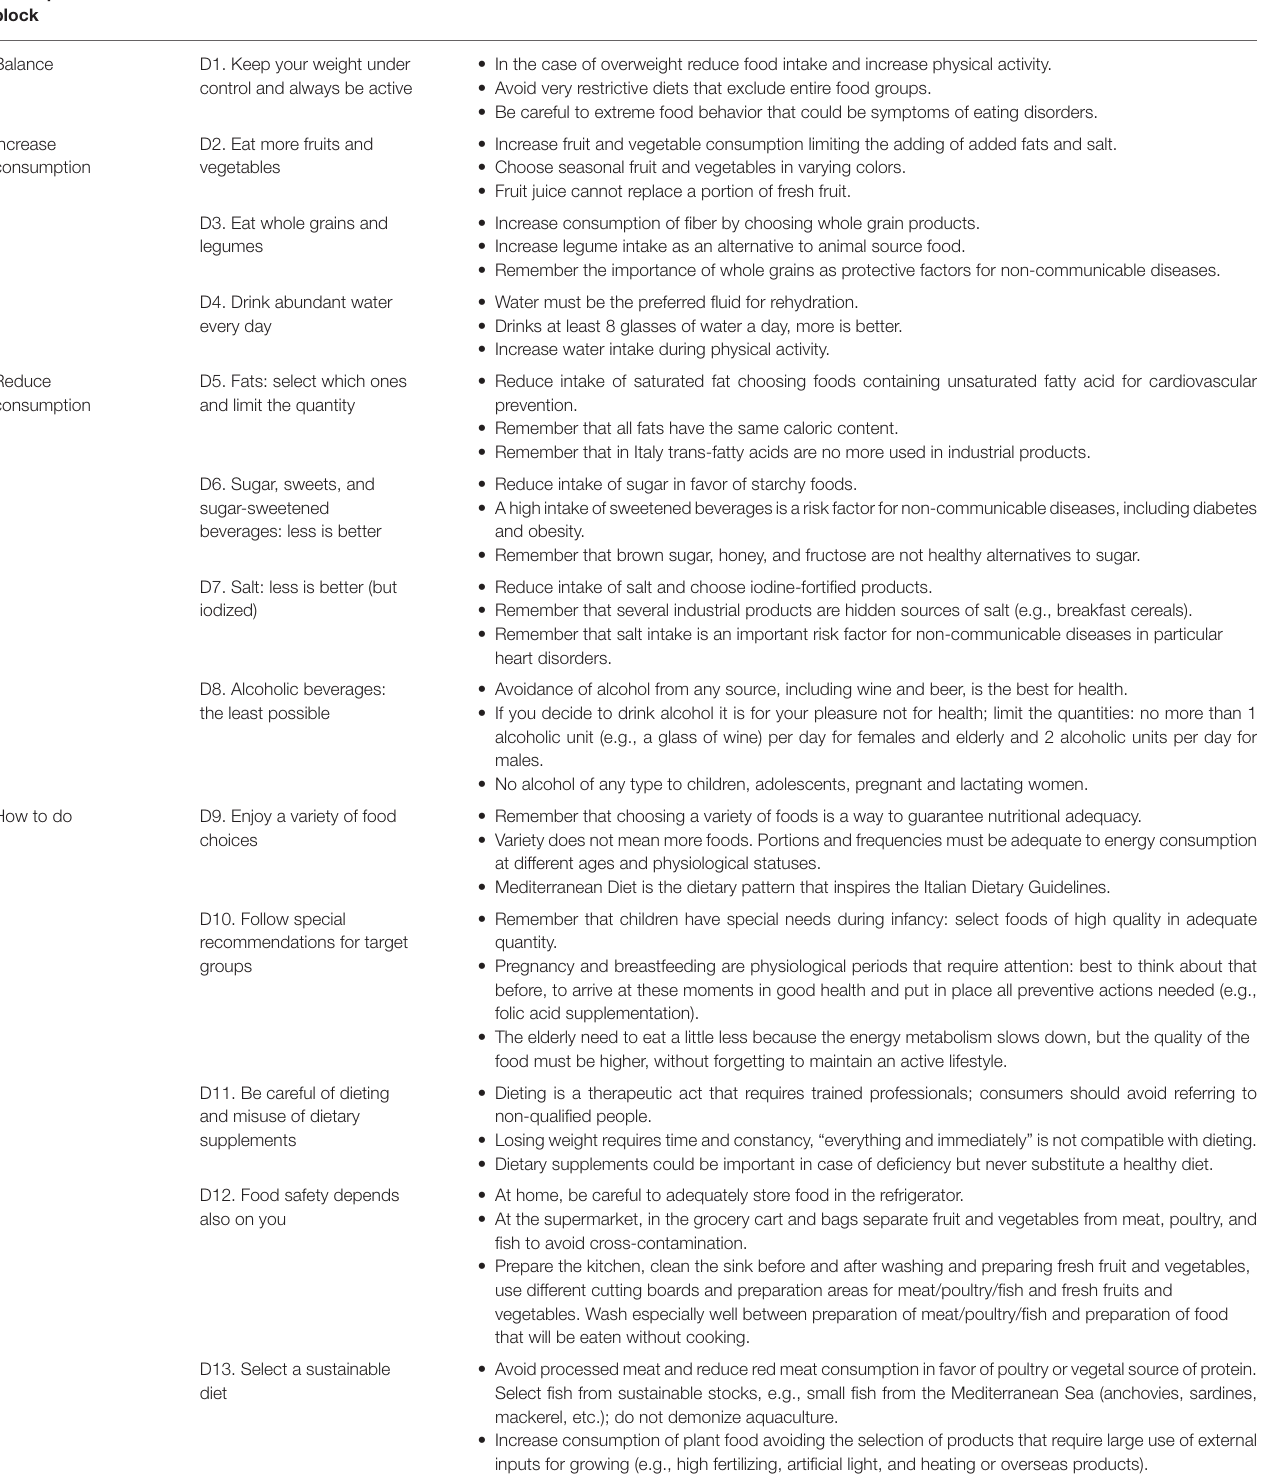
TABLE 1 | The 4 conceptual blocks, the 13 directives, and the main recommendations of each directive. Conceptual block